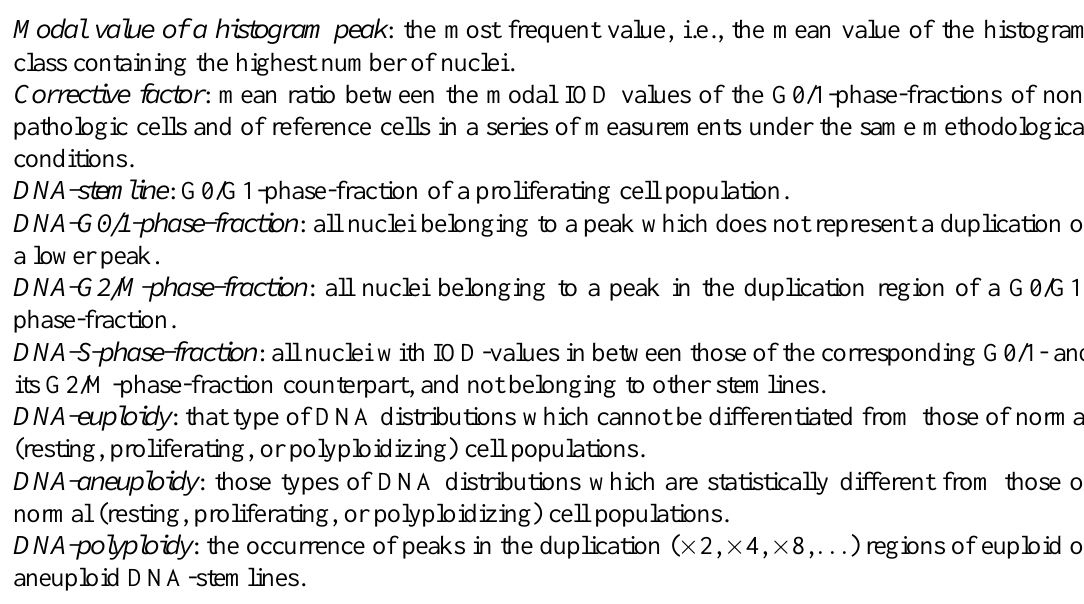
Fig. 1. Descriptors of a DNA histogram